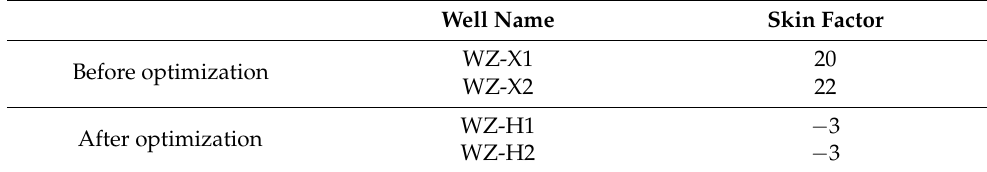
Table 9. Comparison of skin factor.